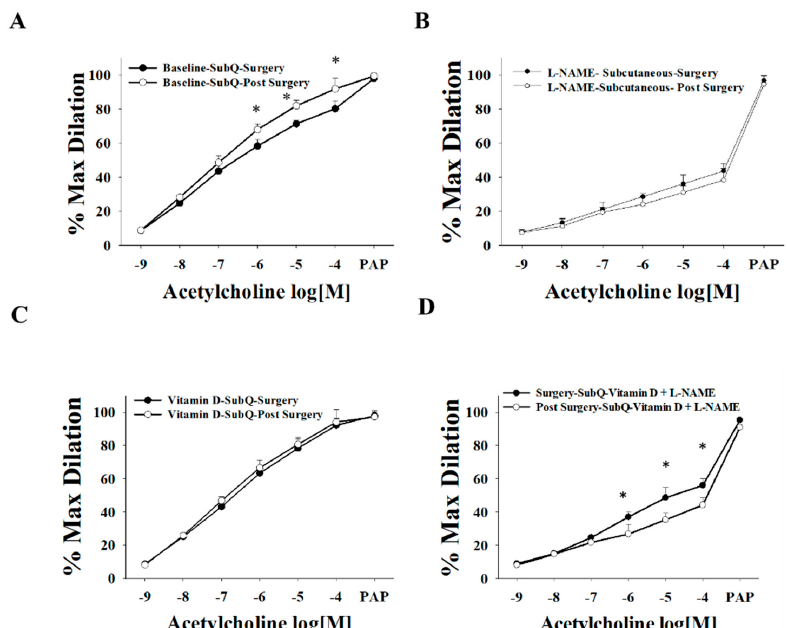
Figure 9. Comparison of the AchID between SAT arterioles collected on the day of bariatric surgery and those collected three months after surgery. AchID measurements corresponding to increasing Ach concentrations (10 − 9 to 10 − 4 M) in SAT arterioles at baseline ( A ) and after incubation with L-NAME ( B ), vitamin D ( C ), and vitamin D plus L-NAME ( D ). All measures are represented as means ± SE; * p < 0.05 comparing post-surgery with surgery-obtained arterioles.